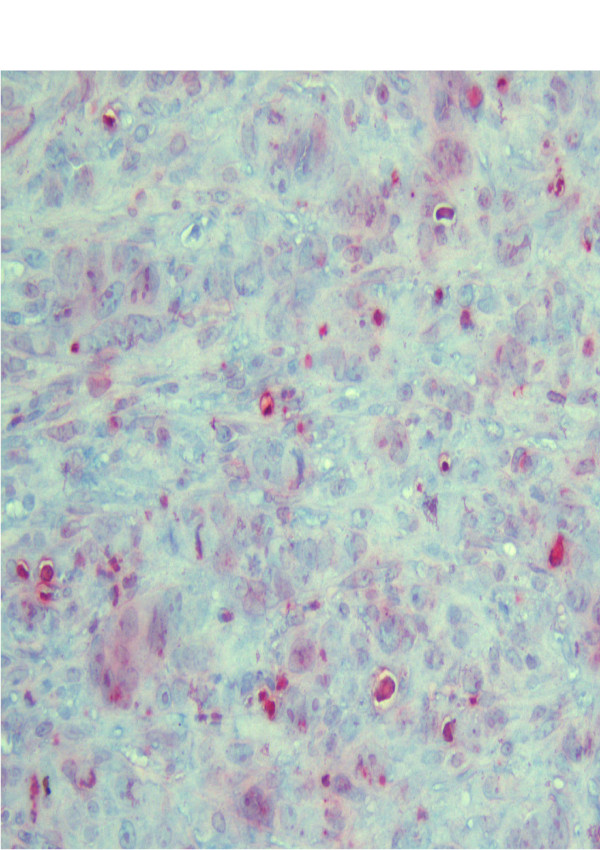
Immunohistochemical staining for group IV (HIPEC): Apoptosis are represented by red clusters. The index represented the number of visible apoptotic cancer cells in five fields.